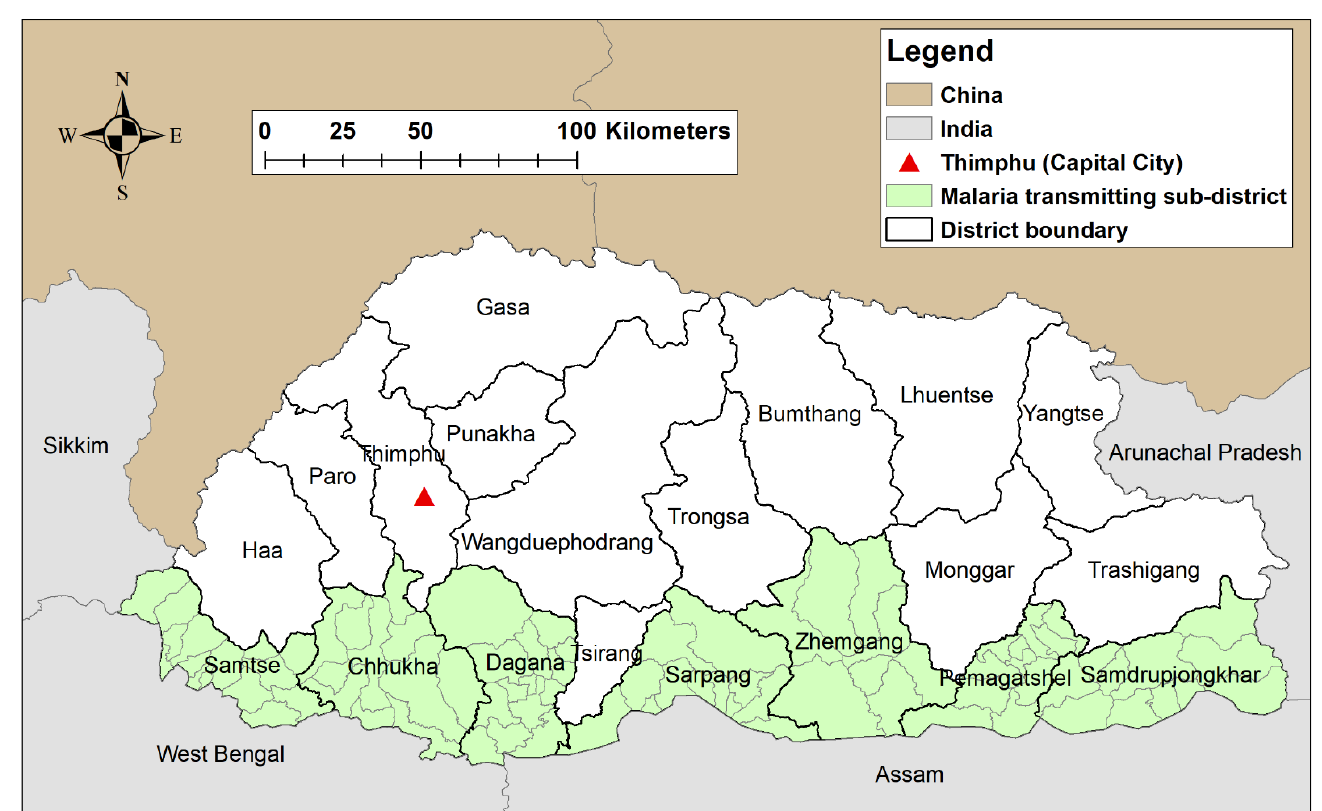
Figure 1. Map of Bhutan with malaria-transmitting districts and sub-districts.